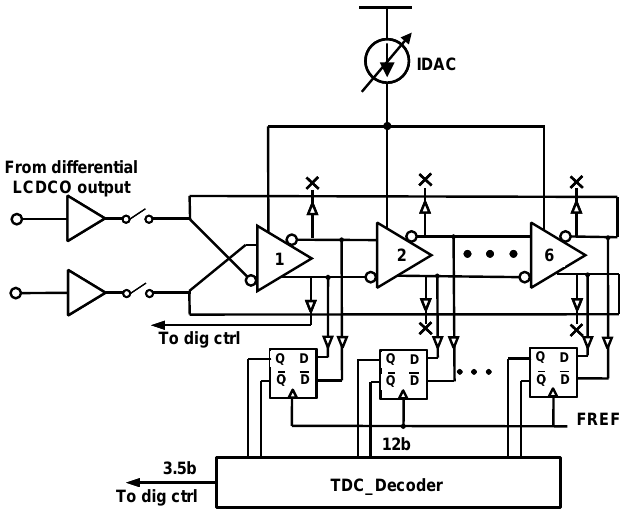
Figure 10. Circuit implementation of the injection-locked RO-based TDC.